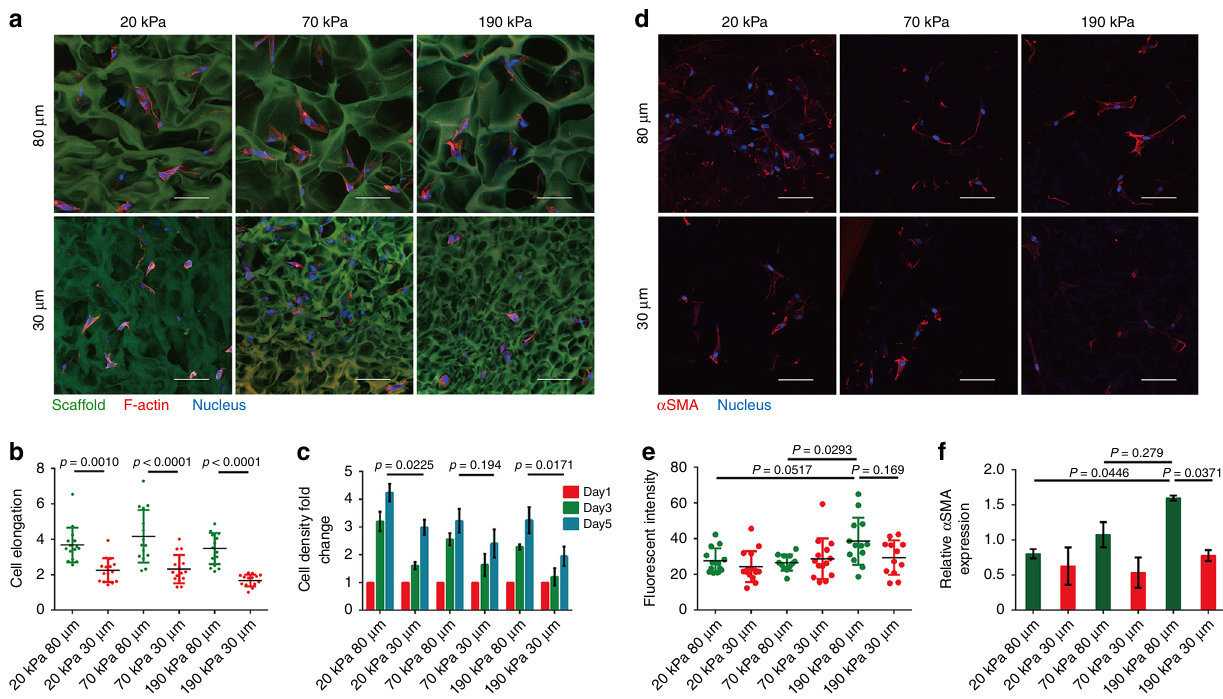
Fig. 3 Fibroblasts respond to the stiffness and pore size of 3D porous scaffolds. a , b Confocal fl uorescent imaging of F-actin-stained HDFs within auto- fl uorescent scaffolds showing elongation of HDFs within large-pore scaffolds regardless of scaffold stiffness; whereas cell elongation only occurred in small-pore scaffolds with lower local stiffness (20 kPa) but not in stiffer scaffolds. Scale bar: 50 μ m ( n = 15). c Proliferation of HDFs inside the different porous scaffolds over 5 days of culturing ( n = 3). d , e Signi fi cant α SMA expression with fi ber-like accumulation was only observed in scaffolds with larger and stiffer pores (80 μ m and 190 kPa). Scale bar: 50 μ m. ( n ≥ 12). f Gene expression levels for α SMA ( n = 3). Data are means± s.d.